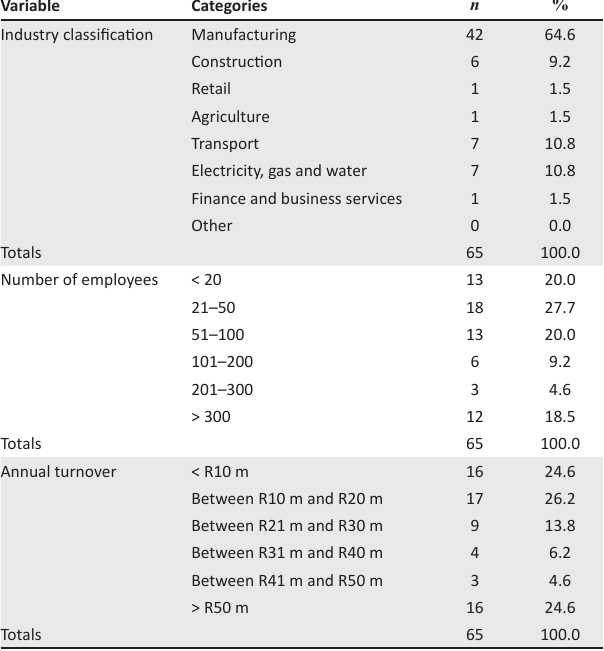
TABLE 1: Profile of participating small and medium